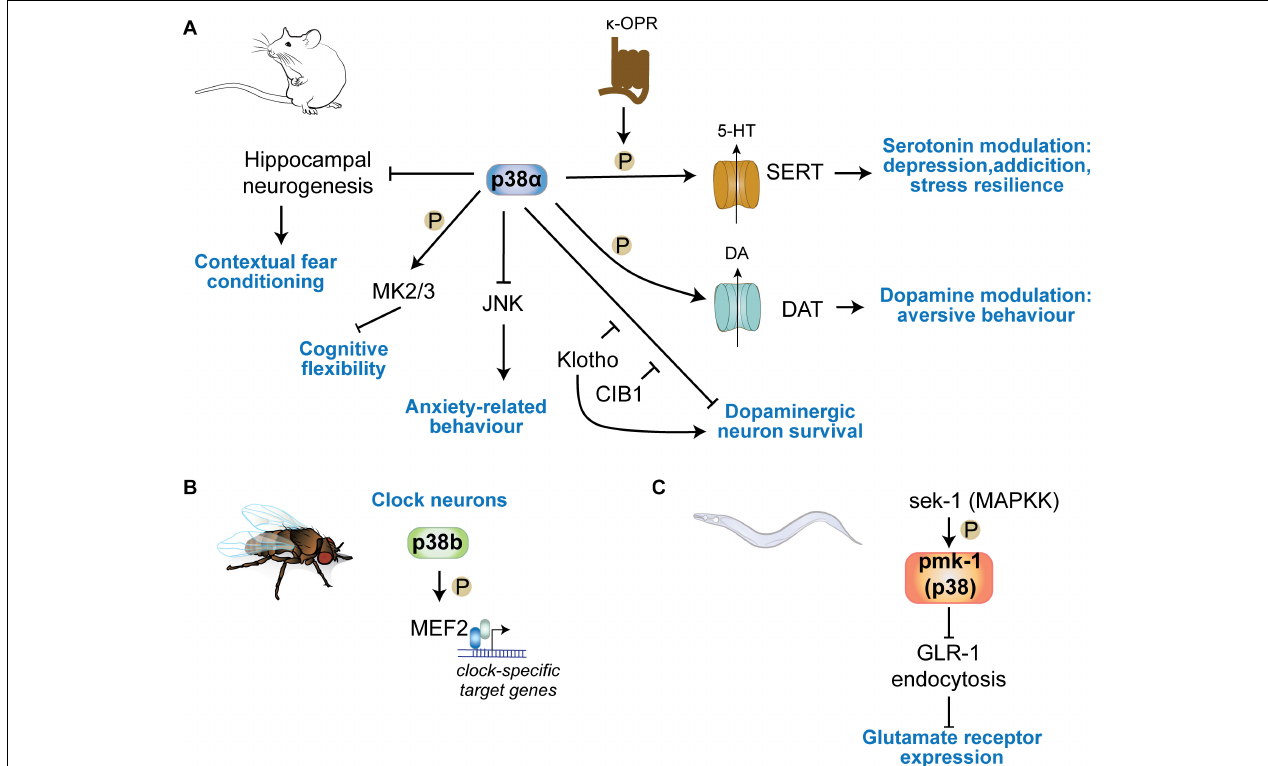
FIGURE 4 | p38 kinases in physiologic central nervous functions. (A) p38 α regulates learning in contextual fear conditioning through regulation of hippocampal neurogenesis. Neuronal p38 α inhibits JNK activation in neurons to modulate anxiety-related behavior. p38 α downstream of κ -opioid channels regulates serotonin reuptake in serotonergic cells by direct phosphorylation of SERT. This mechanism is involved in serotonin-regulated aspects of depression, addiction, social defeat stress. DA re-uptake by phosphorylation of DAT in DA neurons. (B) p38b regulates circadian rhythms in Drosophila by transcriptional regulation of clock neuron gene expression through the transcription factor MEF2C downstream of p38b. (C) The sek1 pmk1(p38) pathway in C. elegans regulates glutamate receptor GLR-1 trafficking at neuronal